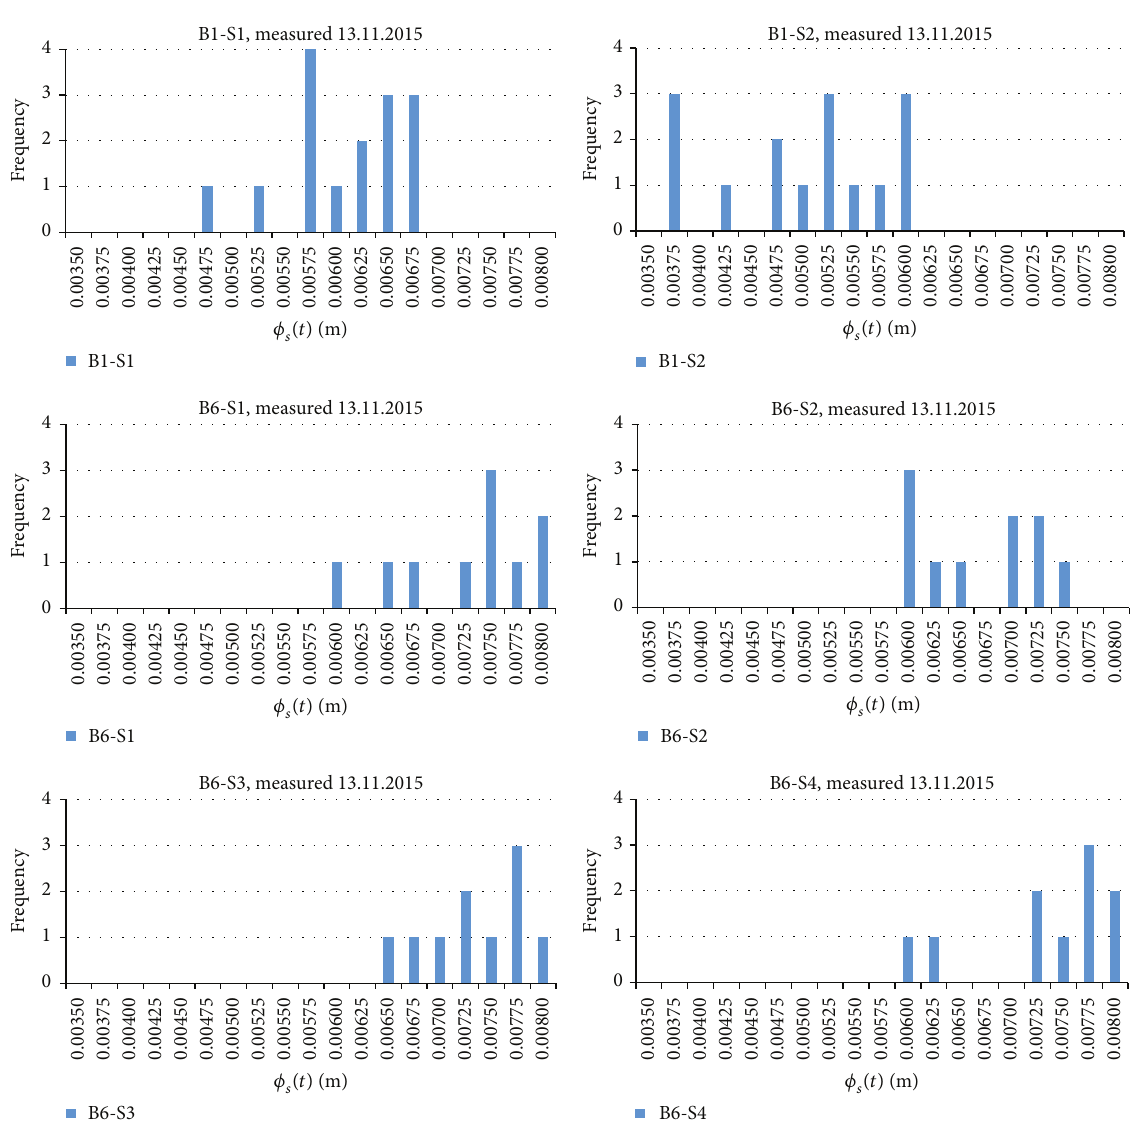
Figure 6: Histograms from measured values of bars’ diameters: